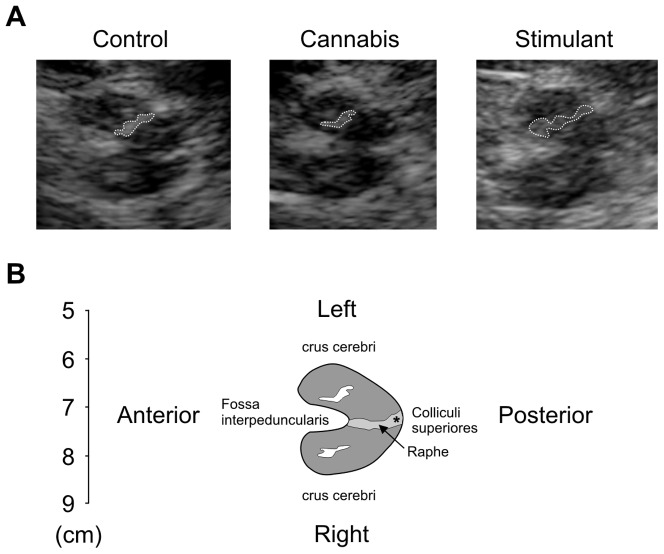
Single subject data showing echomorphology of the mesencephalic brainstem.A) Images from 1 control subject, 1 cannabis subject, and 1 stimulant subject. The substantia nigra ipsilateral to the probe (the side at which the planimetric measurement is done) is encircled with a dotted line. B) Schematic drawing of the mesencephalic brainstem. * aqueduct. Raphe, echogenicity of midline structures.